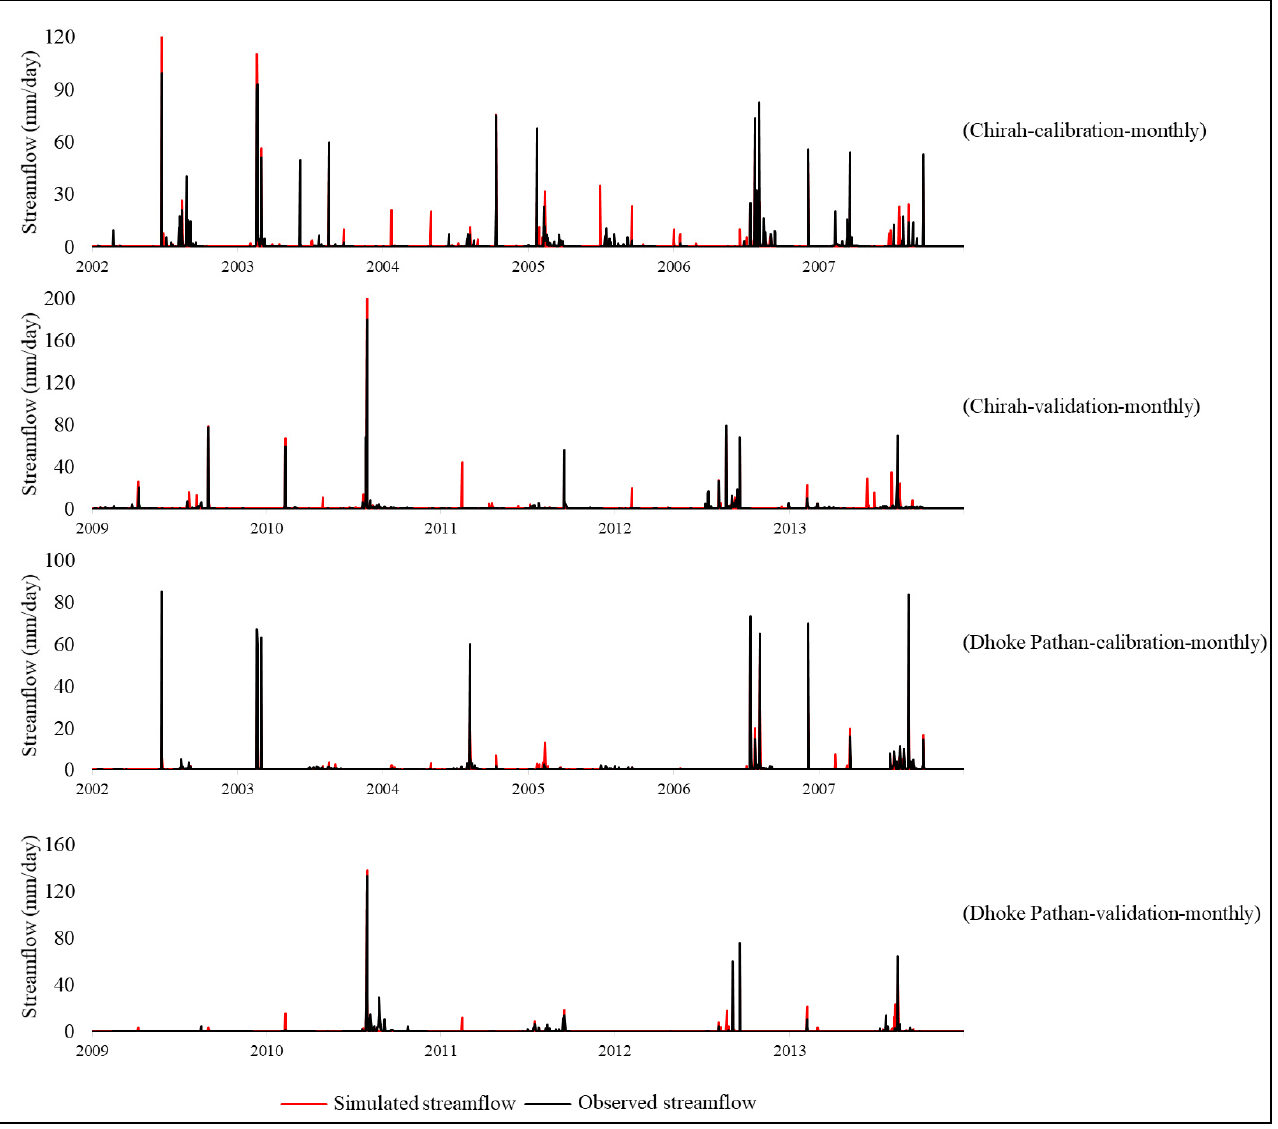
Figure 2. Daily Streamflow during calibration and validations periods simulated by the HBV-light forced with the gauged data in Chirah and Dhoke Pathan sub-catchments.